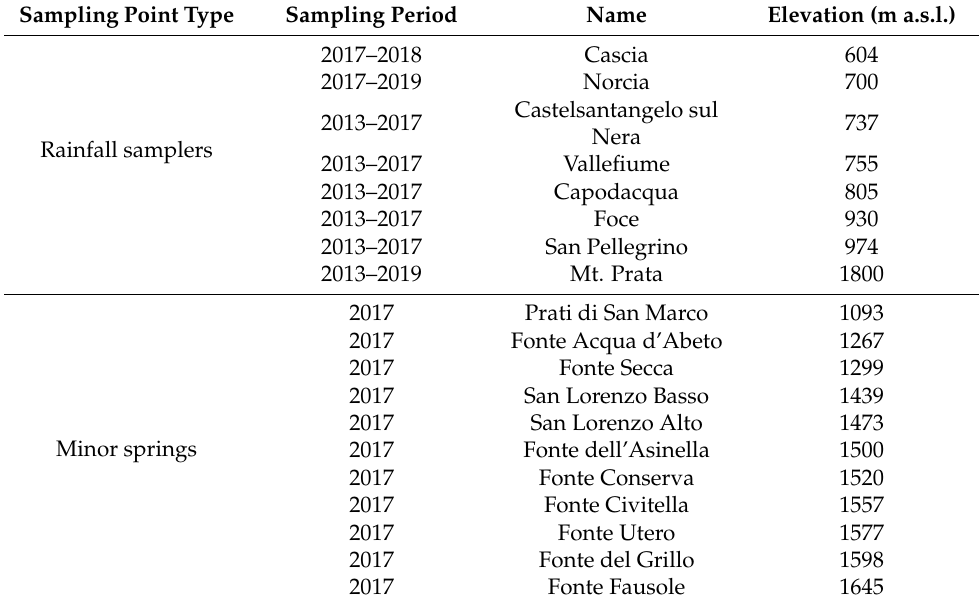
Table 1. Sampling points (rainfall sampler or minor spring) used to determine the δ 18 O content at different elevation in the study